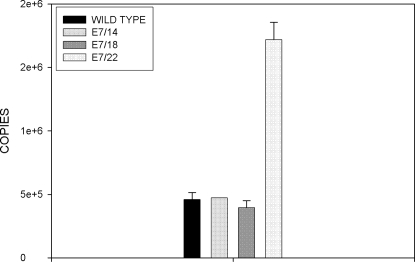
Quantitative RT PCR analysis on total RNA from cells transiently transfected with wild type E7 or codon-modified E7 expression constructs demonstrated that E7/22 message was present at about four times the numbers of copies of the other genes.RNA was isolated from transiently transfected cells and subjected to QRT- PCR. Standard curves were run with each reaction and quantitation of message was done using these curves. E7/22 message was present at levels four fold higher than the other genes.